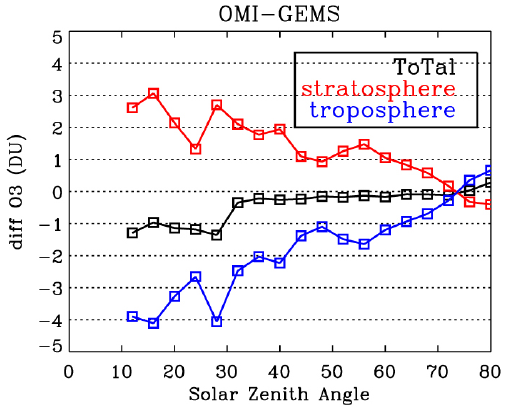
Fig. 8. Direct comparisons of total/stratospheric/tropospheric ozone column between OMI and GEMS. The mean biases of OMI–GEMS ozone columns from retrievals of orbit 9522 on 30 April 2006 are plotted as a function of solar zenith